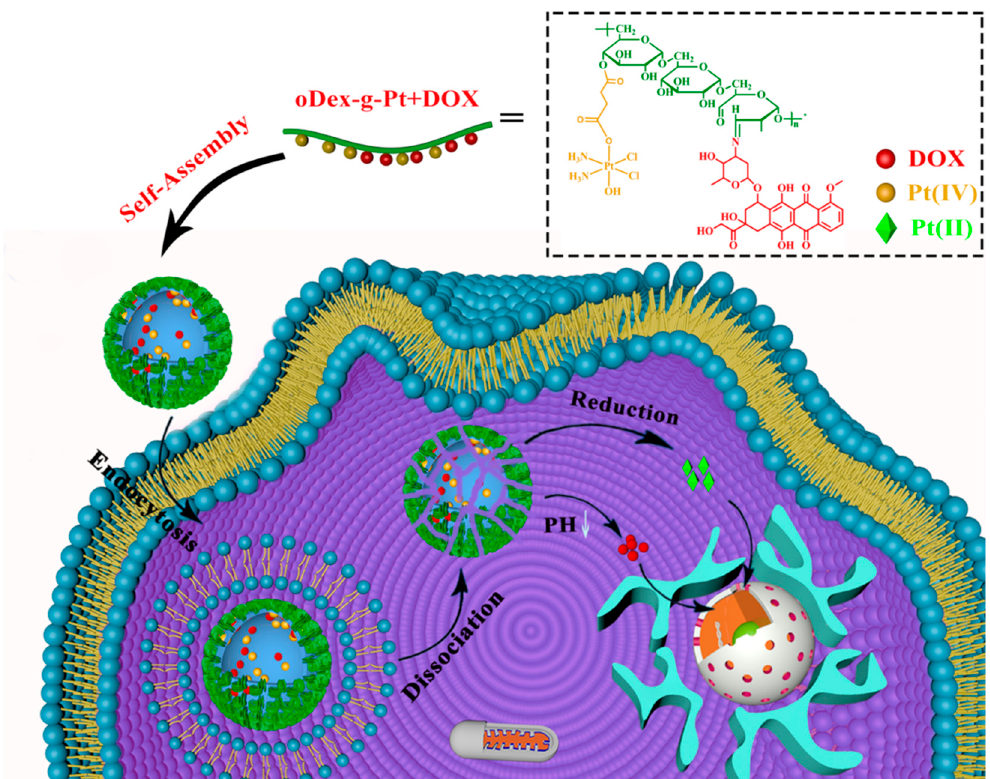
Scheme 1. Schematic representation of the self-assembly of oDex-g-Pt+DOX (platinum plus DOX conjugated oxidized dextran), and its intracellular action after endocytosis for combinational chemotherapy.